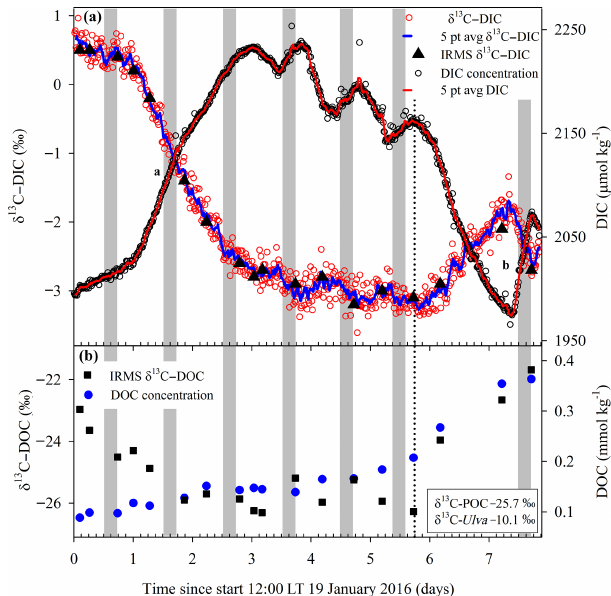
Figure 4. (a) δ 13 C-DIC values and DIC concentrations measured by the AIRICA–CRDS system during the ∼ 8-day laboratory bloom experiment. Blue and red lines are 5-point averages for δ 13 C-DIC and DIC respectively. Black triangles are discrete IRMS δ 13 C-DIC values plotted for comparison. Shaded areas indicate dark incuba- tions. Lower-case letters indicate the sections used for Keeling plots (see Fig. S2). Dotted line shows when macroalgae ( Ulva sp.) and additional nutrients were added. (b) IRMS δ 13 C-DOC values and DOC concentrations for discrete samples. Inset box displays IRMS δ 13 C values for POC and Ulva sp.